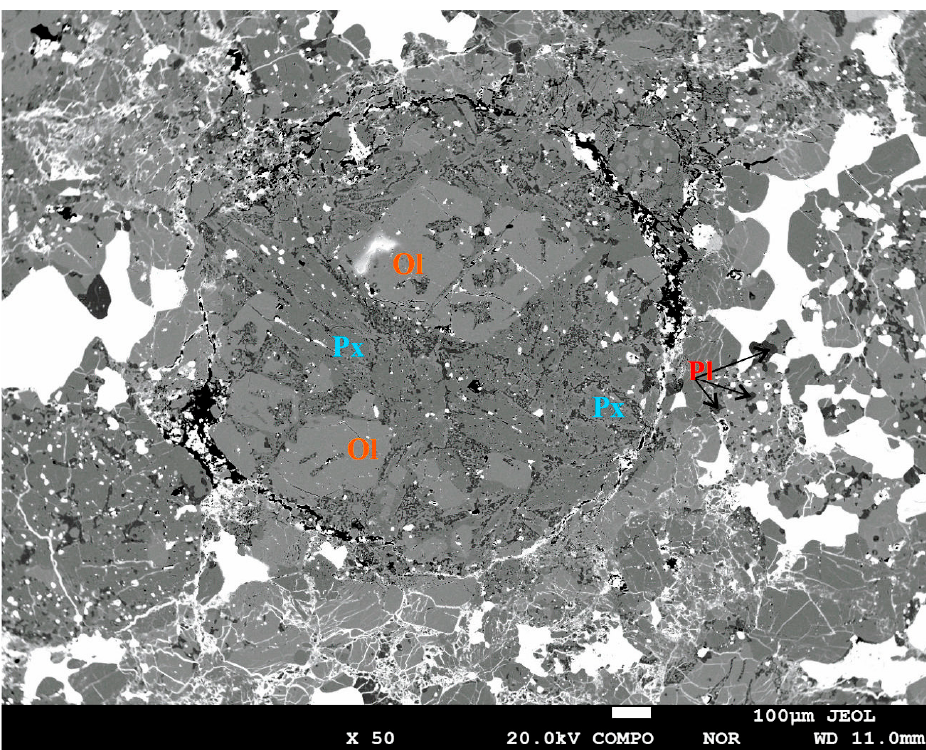
Figure 1. BSE image of 1POP-0 chondrule from the Kargapole meteorite. Ol–olivine, Px–pyroxene, Pl–plagioclase.